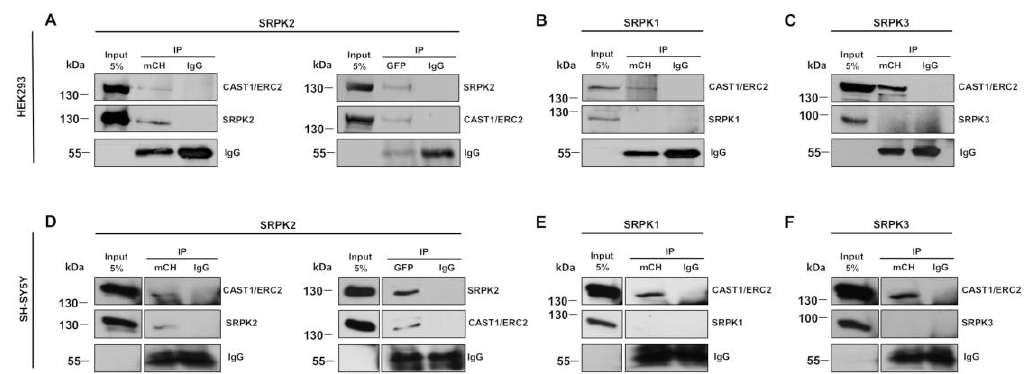
Figure 7. CAST1 / ERC2 interacts with SRPK2 in HEK293T and SH-SY5Y cells. HEK293T and SH-SY5Y cells were co-transfected with EGFP-SRPK1, EGFP-SRPK2 or EGFP-SRPK3 and mRFP-CAST1 / ERC2 plasmids. Forty-eight hours later, cells were lysed and immunoprecipitated with GFP or mCherry antibody. Normal rabbit IgG was used as a control. Immunoprecipitated proteins were analyzed by Western blotting using mCherry or GFP antibodies, both in ( A ) SRPK2, ( B ) SRPK1 and ( C ) SRPK3 in HEK293T and ( D ) SRPK2, ( E ) SRPK1 and ( F ) SRPK3 in SH-SY5Y cells. For mRFP-ERC2 and EGFP- SRPKs the amounts of plasmid used for transfection of a six-well plate were 2.5 µg/well and 5.0